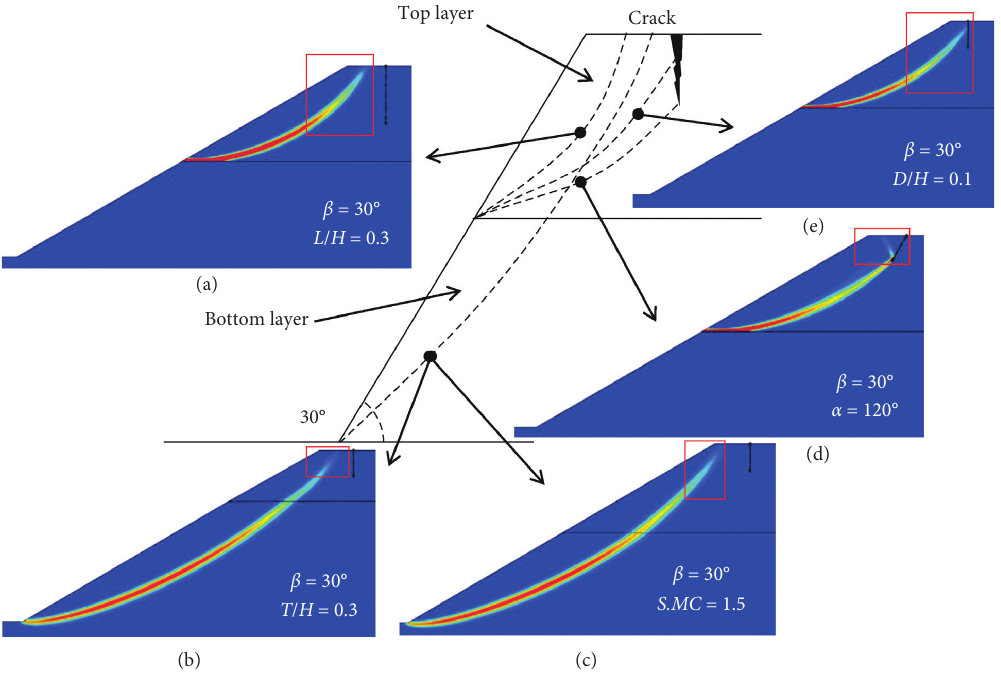
Figure 10: Typical failure modes at different crack